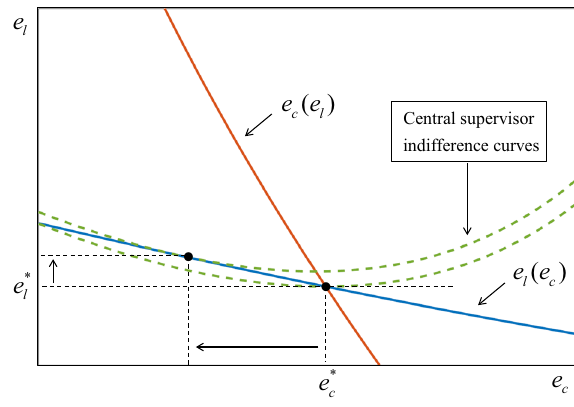
Fig. 9 The central supervisor as a Stackelberg